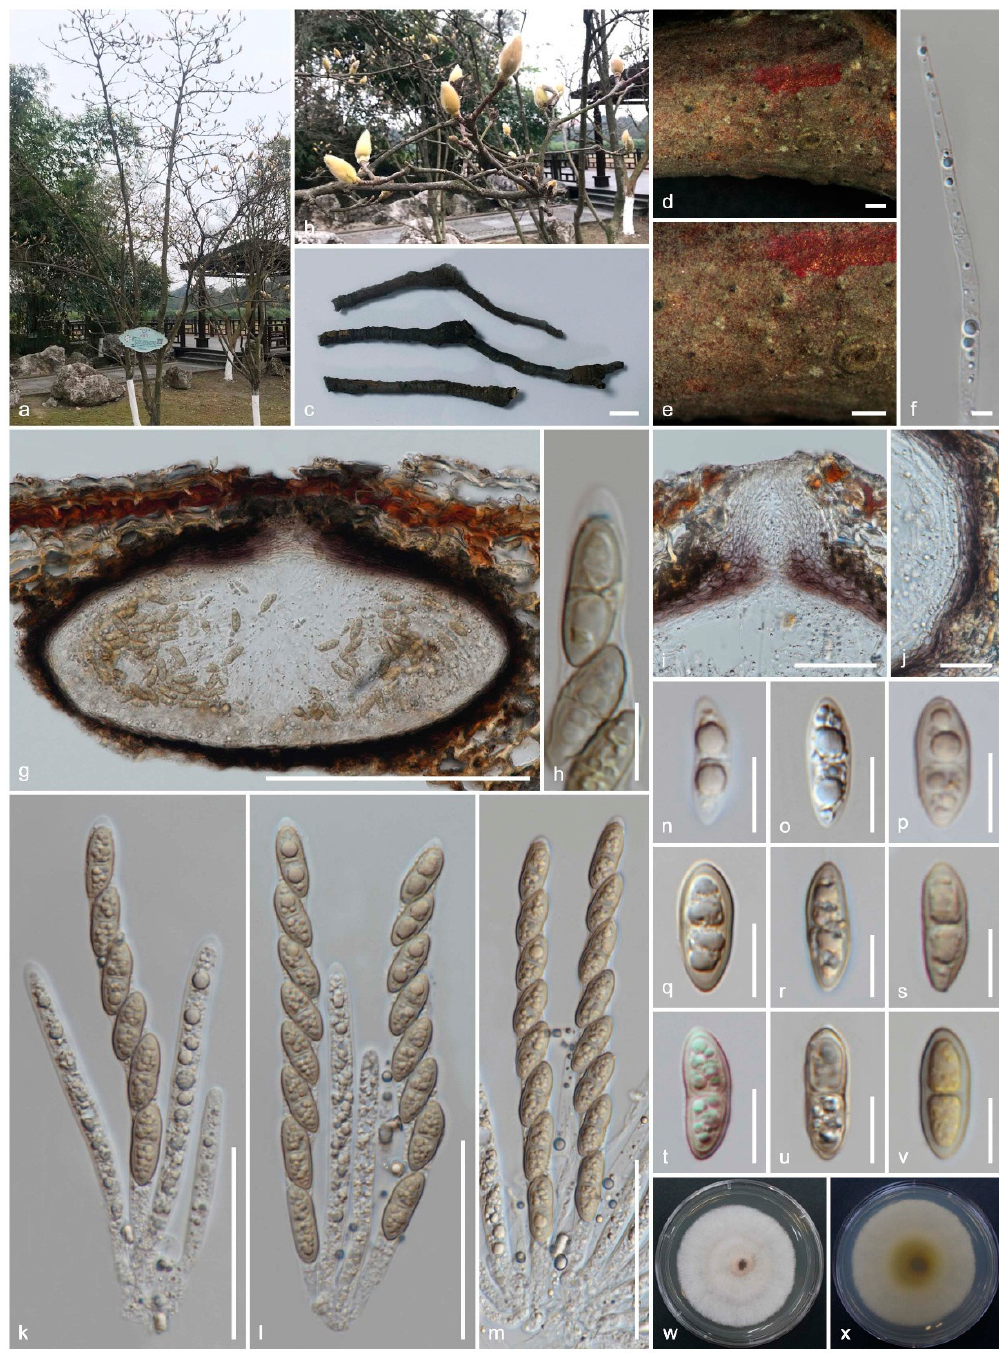
Figure 7. Sexual morph of Amphisphaeria micheliae (HKAS 107012, holotype). ( a , b ) Host Michelia alba ; ( c ) substrate; ( d , e ) ascomata on the substrate; ( f ) paraphyses; ( g ) vertical section of ascoma; ( h ) apical ring bluing in Melzer’s reagent; ( i ) ostiole; ( j ) peridium; ( k – m ) asci; ( n – v ) ascospores (v in Melzer’s reagent); ( w ) upper view, ( x ) reverse view of the 2 weeks old colony on PDA. Scale bars are set at ( c ) 1 cm; ( d , e ) 500 μ m; ( g ) 200 μ m; ( i , k – m ) 50 μ m; ( j ) 20 μ m; ( h , n – v ) 10 μ m. MycoBank: MB836112; Faceso ff ungi number: FoF08752 Saprobic on a dead branch of Michelia alba . Sexual morph: Ascomata: 180–210 μ m high × 225–370 Etymology: The specific epithet reflects the host genus Michelia . μ m diameter (M = 190 × 300 μ m, n = 8), immersed, visible as black spots in light coloured area on the Holotype: HKAS host, solitary, scattered, subglobose to oblate, papillate ostiole 60–76 μ m high × 34–50 μ m diam. (M = 68 × 42 μ m, n = 8), centric. Periphyses: 1–2 μ m wide (M = 1.5 μ m, n = 20), hyaline, short. Peridium: two- layered; outer layer: 6.5–11.5 μ m (M = 8.5 μ m, n =10), dense, reddish brown cells of textura angularis